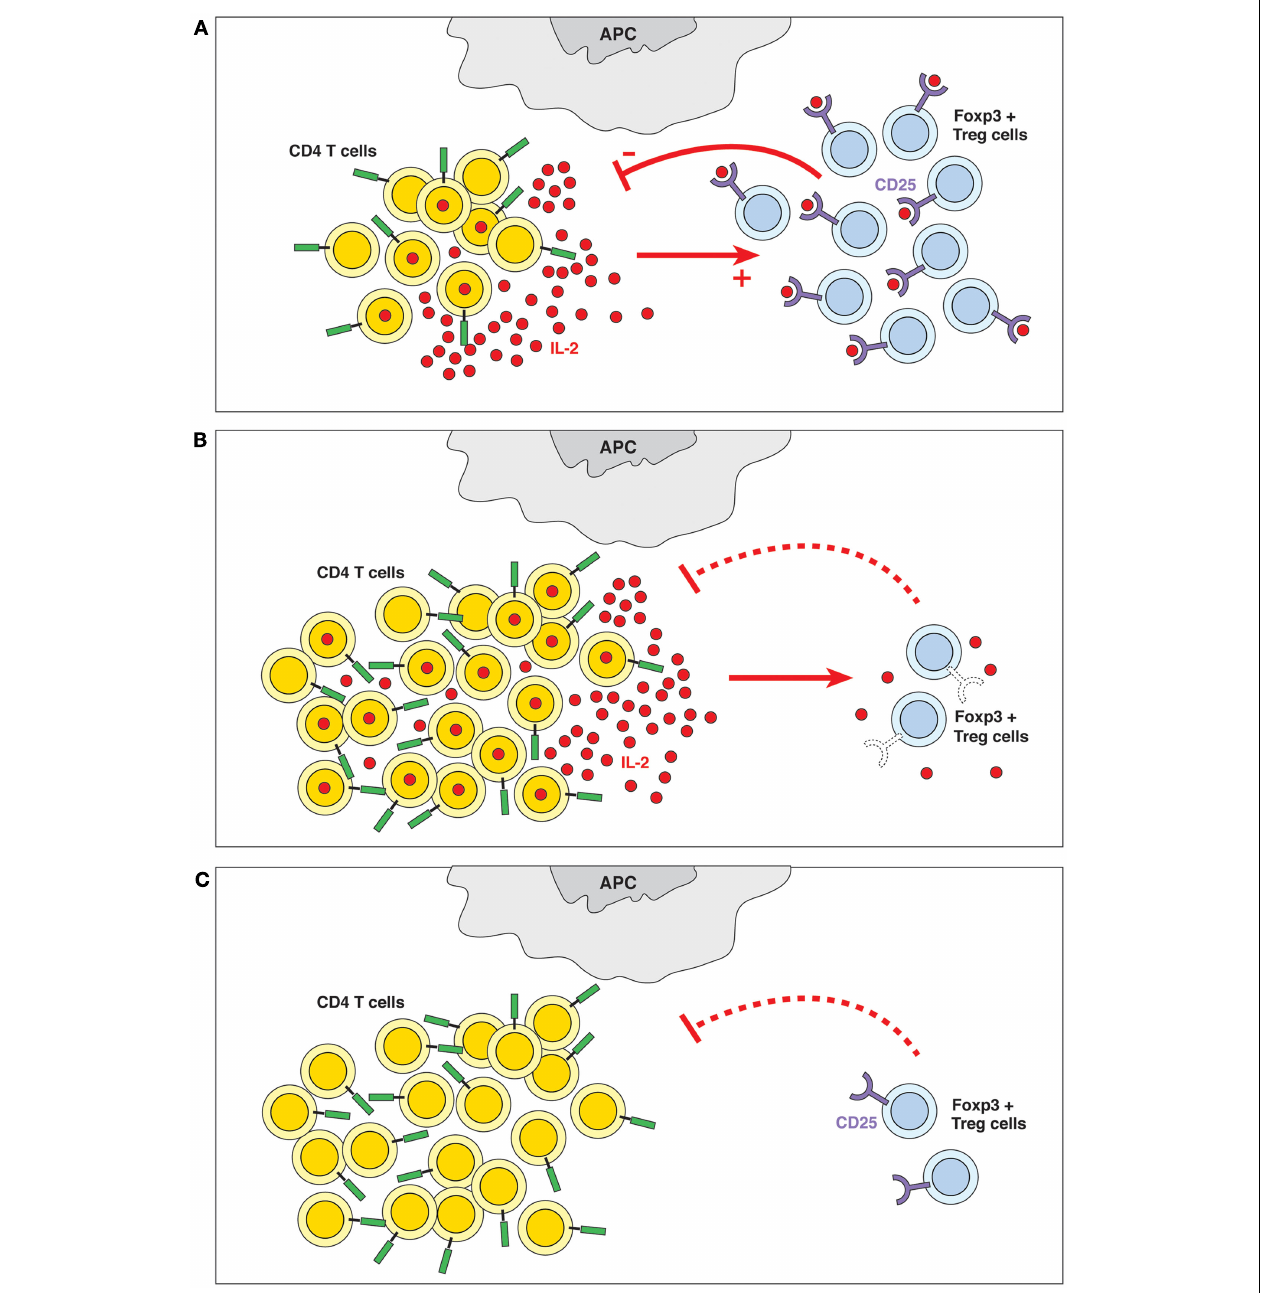
FIGURE 1 | (A) Quorum-sensing.The presence of IL-2 and the ability of the Treg cells to detect its levels are crucial to the homeostasis of the immune system. Quorum-sensing in this case is defined as an indirect feedback loop where the IL-2 produced by a subpopulation of activatedT cells (among others) is detected (sensed) by a subpopulation of CD4 + Treg cells expressing the high-affinity IL-2R α -chain; these cells contribute to controlling the number of CD4 + T cells. In other words, the overall CD4 + T cell populations sense the